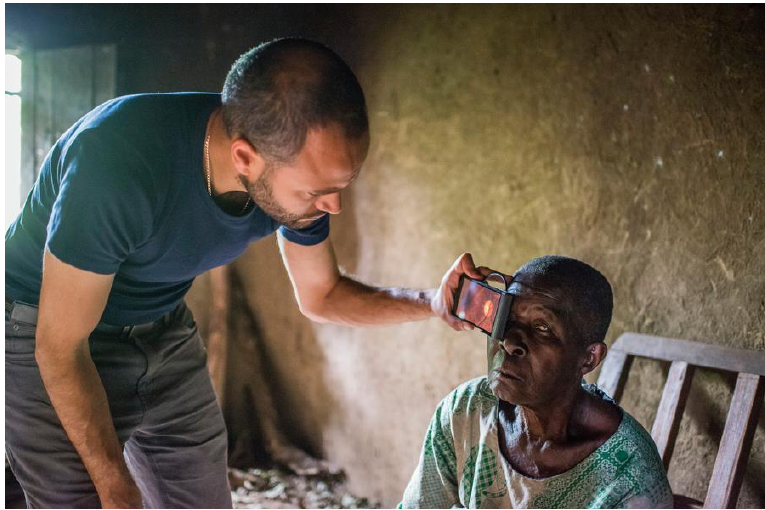
Figure 1. Smartphone based eye examination of a blind woman in Kenya. This work is being performed by the PEEK Vision Foundation [3,4]. © Rolex/Joan Bardeletti.